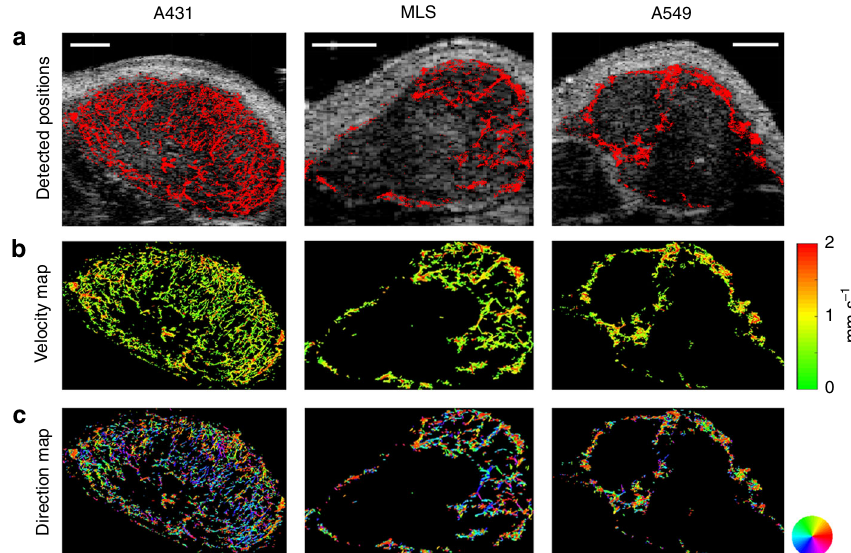
Fig. 2 mULM-based parameter maps of tumors with different vascular phenotypes. The color-coded maps indicate a the detected positions of MB overlaid on the B-mode images, representing the relative blood volume, b individual MB velocities, and c directions of MB fl ow. Scale bars = 1 mm. The three tumor models can be distinguished based on their different vascular patterns and quantitative textural analysis can be performed based on the super-resolution parameter